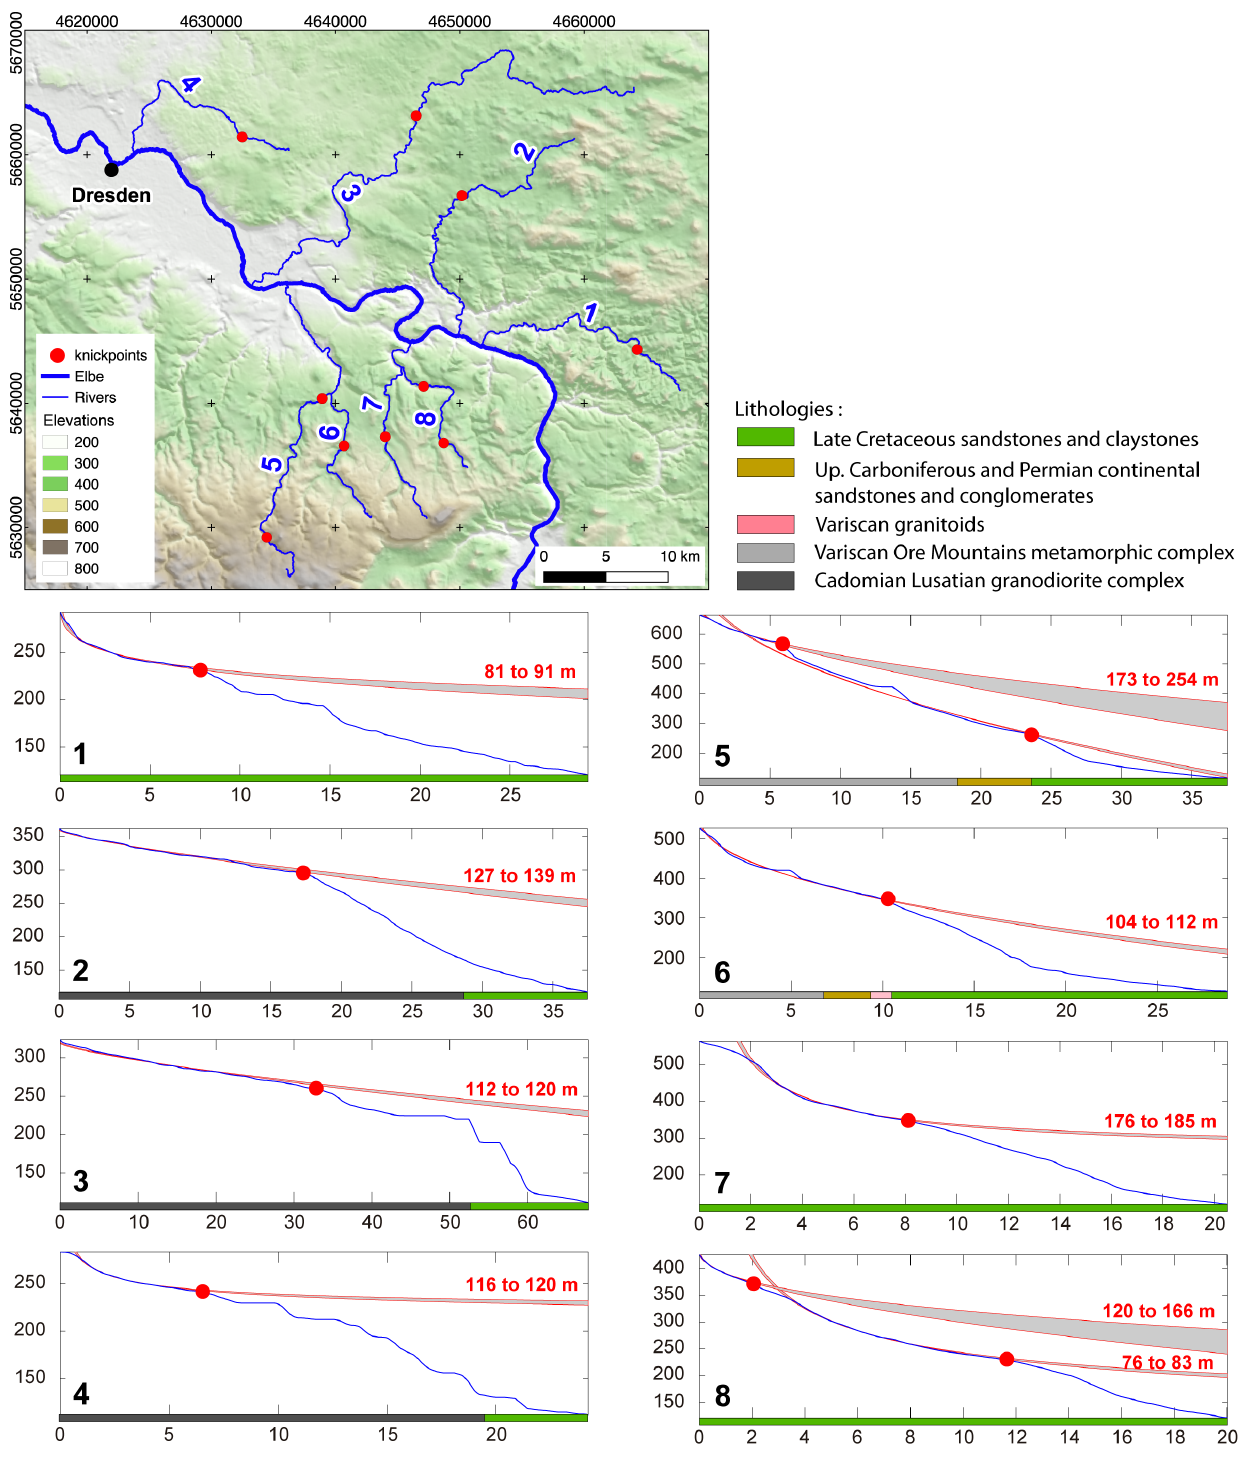
Figure 13. Examples of longitudinal river profiles from the tributaries of the Elbe River. Red points indicate the main knickpoints. Red lines and grey shades show reconstructed profiles using segments located above knickpoints (the method is explained in Figure 6C). Distances are in kilometers, and elevations are in